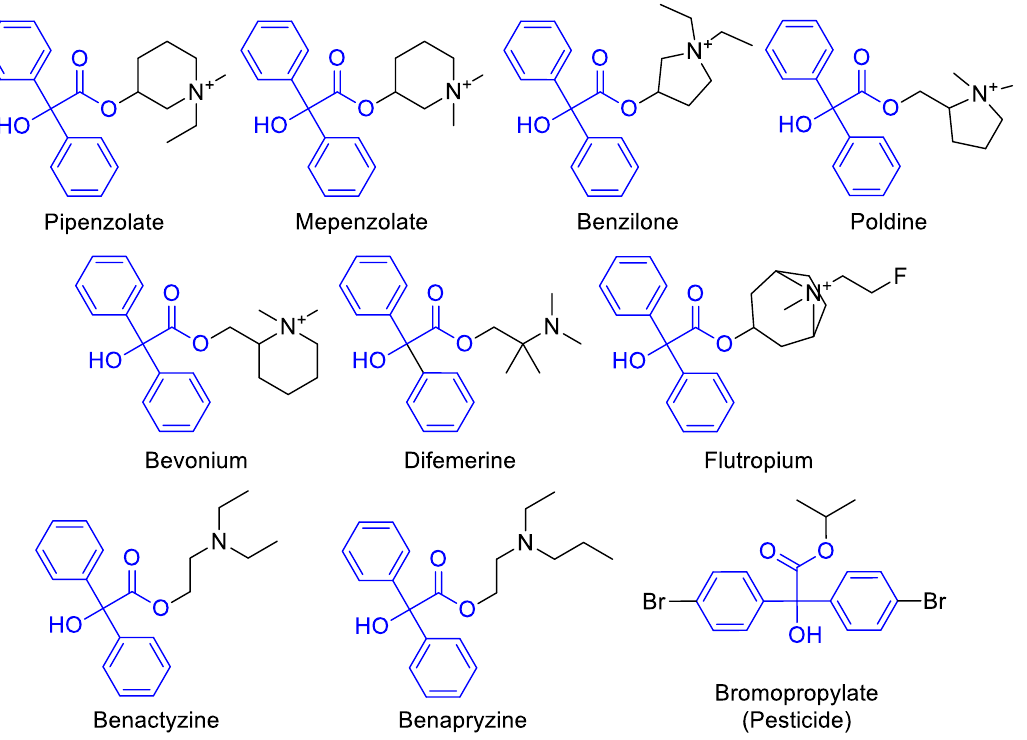
Figure 6. Representative examples of medicinal or agrochemical agents containing diphenylacetyl core structure.